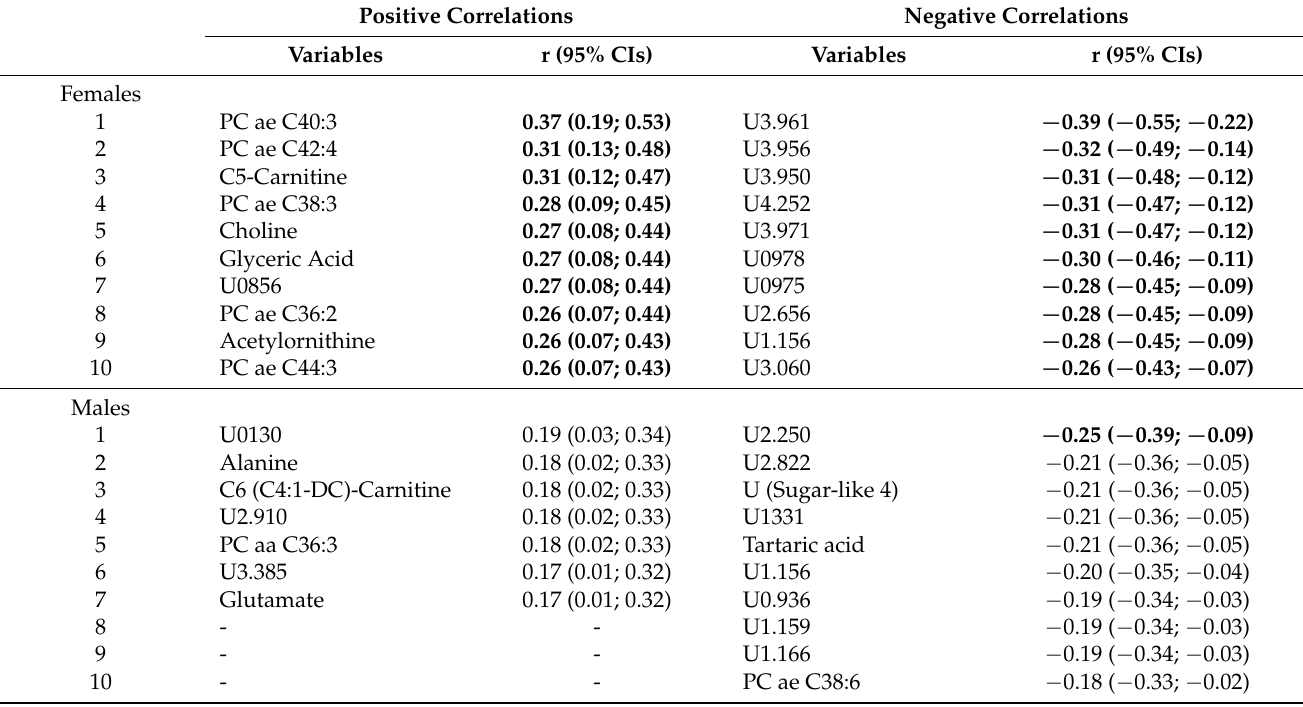
Pearson correlations were performed on Van der Waerden (VdW)-transformed data and results of partial correlations adjusted for age, menopausal status, and further phenotypical/clinical variables are presented. Pearson correlation coefficients (r) and the lower and upper limit of the 95% confidence intervals (CIs) are rounded to two decimal places. |r| ≥ 0.25 are indicated in bold. PC aa: diacyl- phosphatidylcholine; PC ae: acyl-alkyl-phosphatidylcholine; U: unknown. For unknown NMR-analytes, the chemical shift of the lower bucket border is indicated in